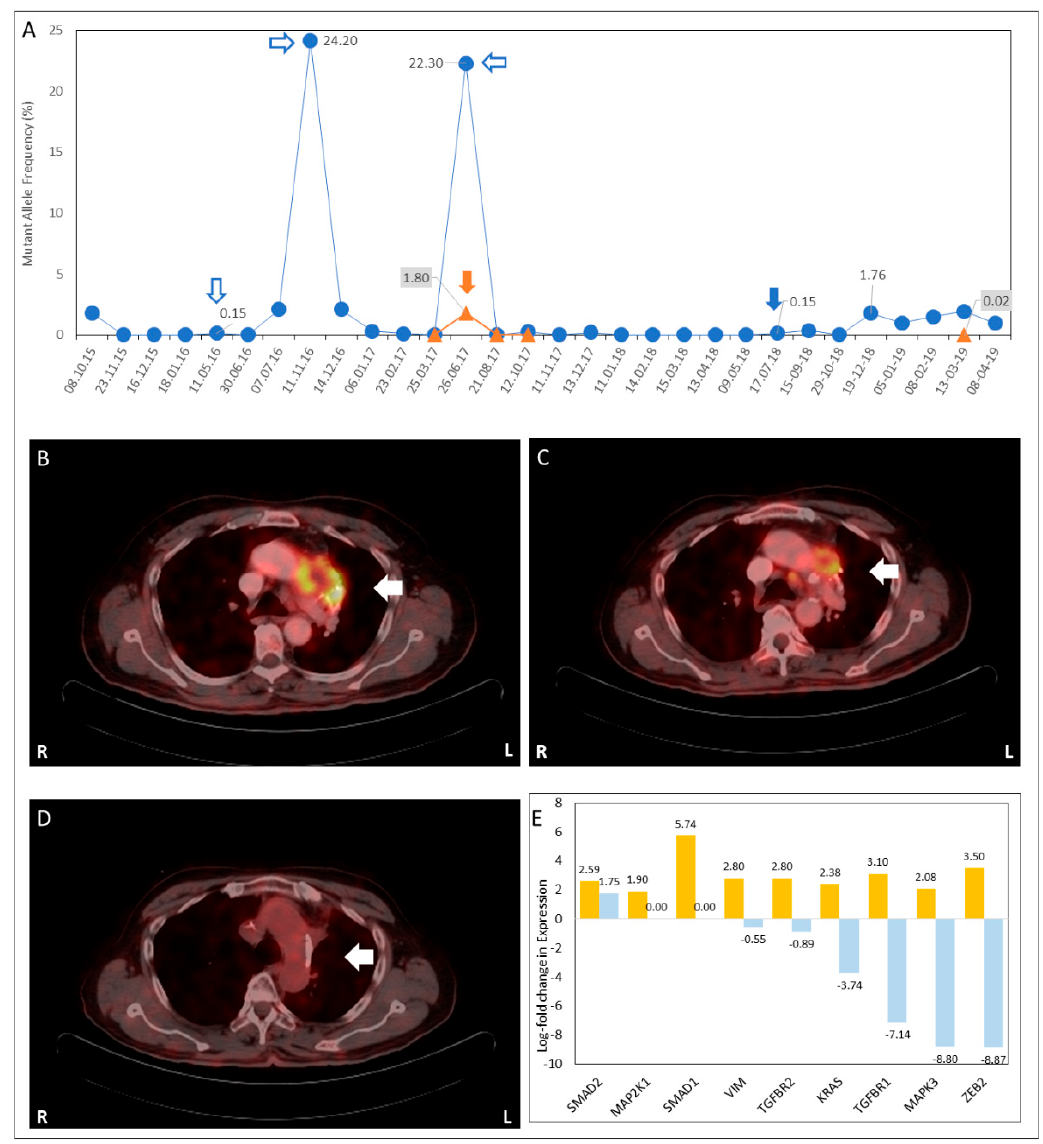
Figure 1. Trends in mutant allele frequency of Epidermal Growth Factor Receptor (EGFR)